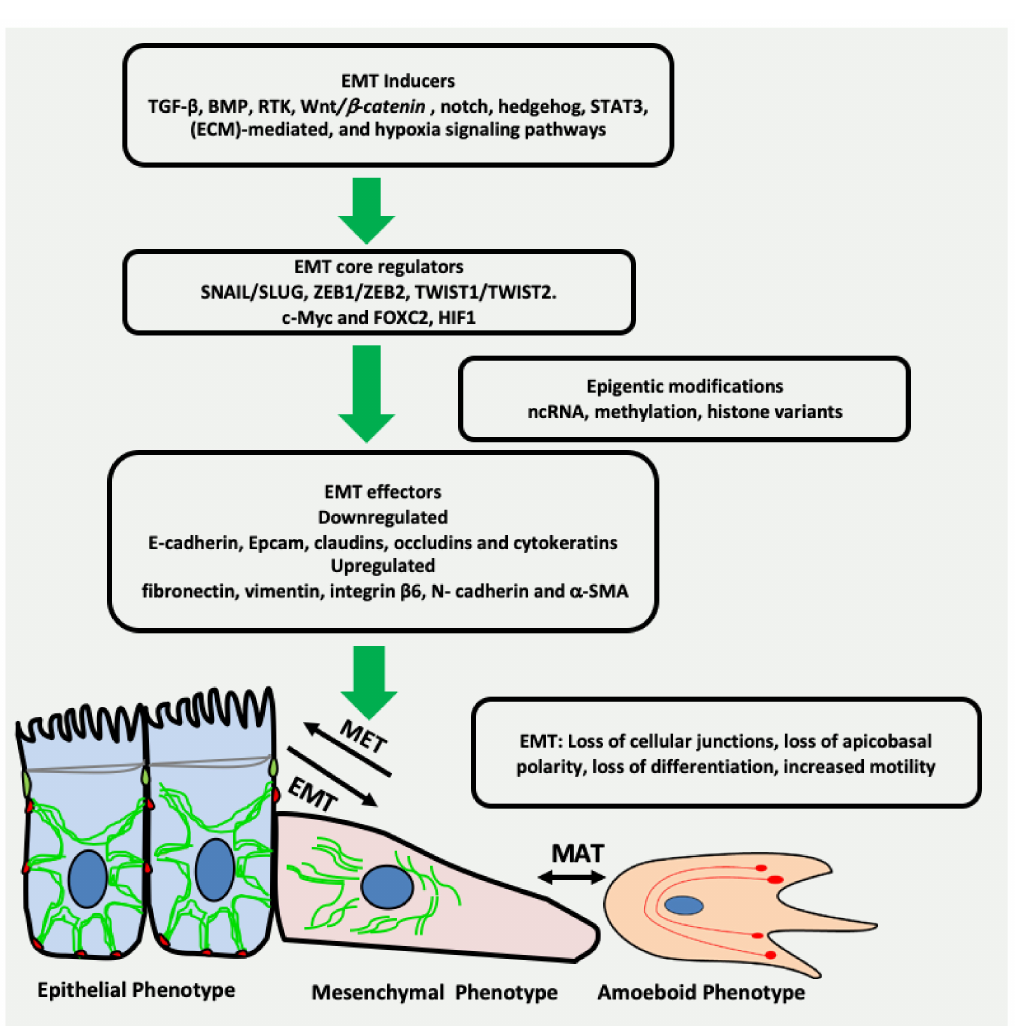
Figure 1. Key events in EMT. Multiple growth factors, microenvironmental factors and other EMT inducers activate the transcription factors related to EMT. As a result, there is downregulation of the genes related to cell junctions and differentiation. Moreover, the genes specific to mesenchymal phenotype such as vimentin are upregulated, resulting in loss of intercellular junctions, apicobasal polarity, differentiation and increased cell motility, ultimately leading to cancer invasion. ncRNA = non-coding